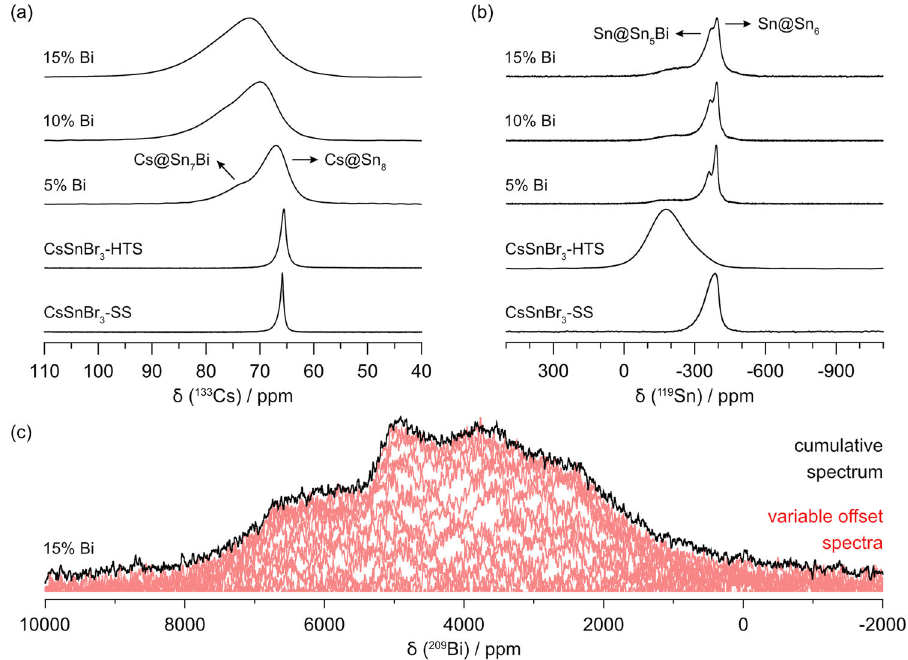
Fig. 2 Multinuclear magnetic resonance of CsSnBr 3 and Bi-substituted materials. a 133 Cs and b 119 Sn MAS NMR spectra (B 0 = 11.75 T, ω r /2 π = 14 kHz) for CsSnBr 3 and Bi-substituted compounds. c Non-spinning 209 Bi NMR spectrum for the 15% Bi-substituted compound (B 0 = 11.75